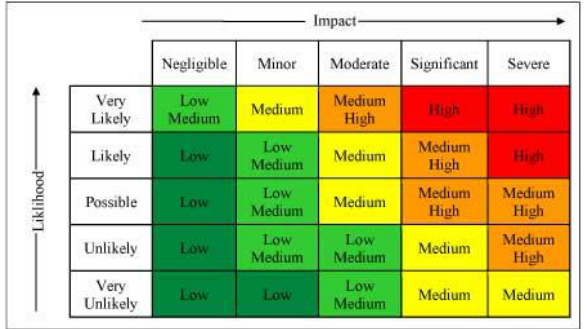
Figure 1: Representative Risk Matrix followed during Risk Assessment, Source- (Boers,